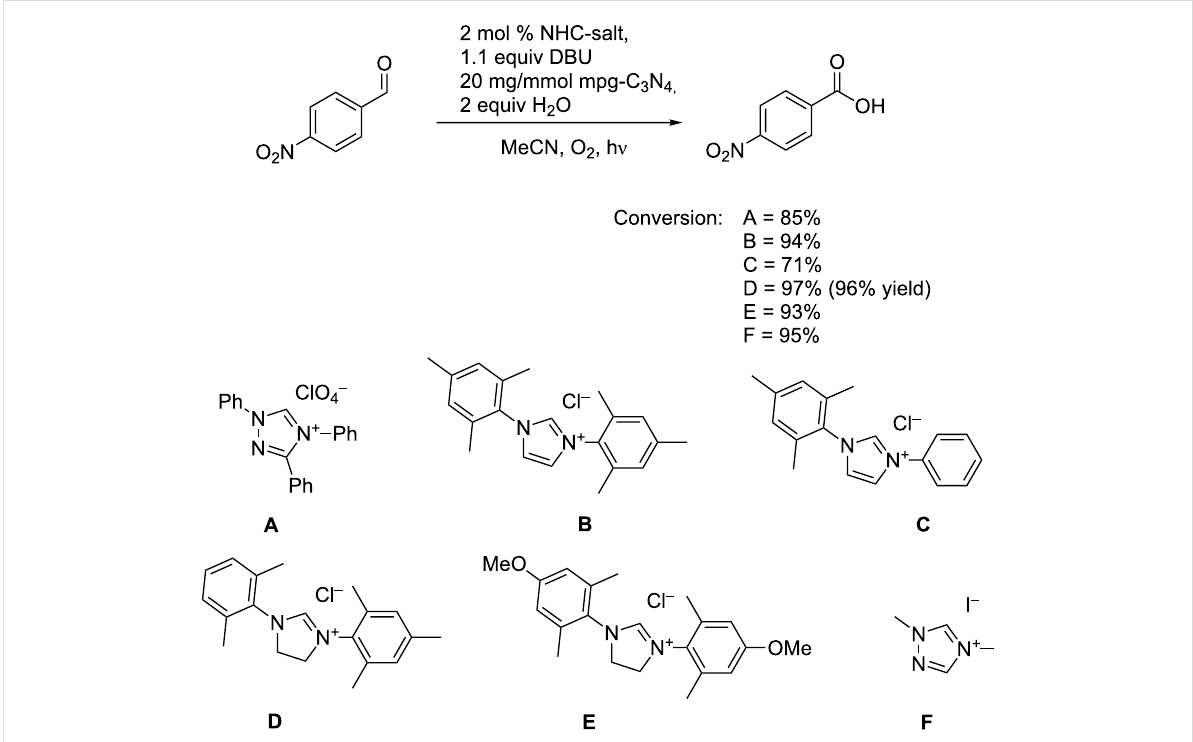
As shown, the accelerating effect decreases over time and